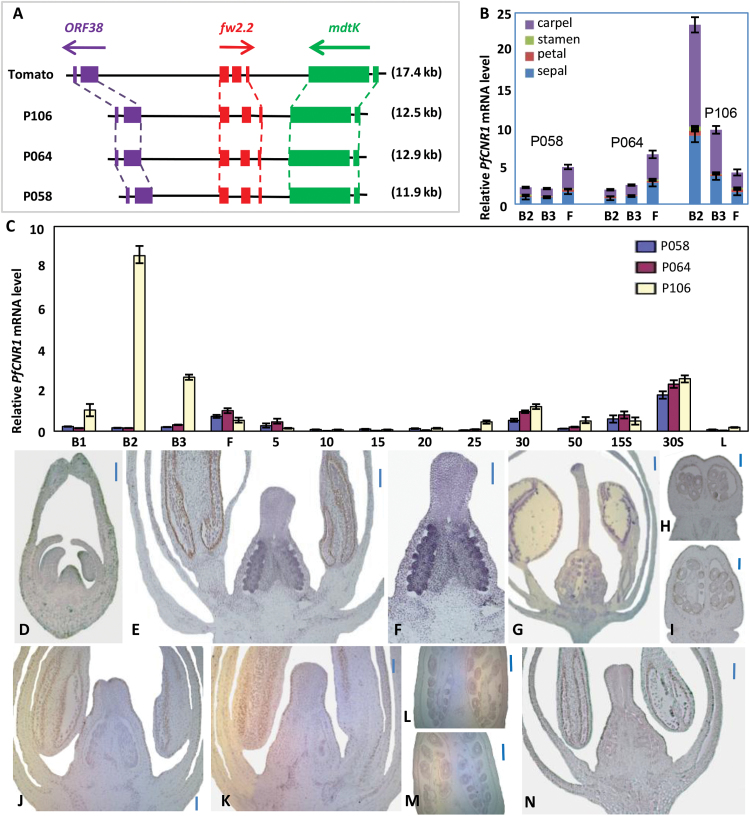
Characterizations of the PfCNR1 gene family. (A) Local synteny of FW2.2 and PfCNR1 between tomato and Physalis species. PfCNR1 genes were isolated from P. philadelphica (P058), P. philadelphica (P064), and P. floridana (P106). The upstream ORF38 of FW2.2 (PfCNR1) encodes an unknown protein, while the downstream gene is mdtK. The full length of each assembled genomic fragment is given in parenthesis. (B) PfCNR1 expression in four floral whorls at anthesis. P. philadelphica (P058), P. philadelphica (P064), and P. floridana (P106) were tested. (C) PfCNR1 expression in Physalis species. Developmental stages were defined as in Fig. 2A and B. 15S, seeds from 15 DPA; 30S, seed from 30 DPA; L, leaf. PfACTIN was used as an internal control. The experiments were performed using three independent biological samples. The mean and standard deviation are presented. (D–i) In situ hybridization of PfCNR1 in P. floridana P106: B1 flower bud (D); B2 flower bud (E); carpel of the B2 flower bud (F); B3 flower bud (G); carpel of the mature flower (H); 5 DPA fruit (I). (J–M) In situ hybridization of PfCNR1 in P. philadelphica P058 and P064: B2 flower bud of P058 (J); B2 flower bud of P064 (K); carpel of the mature flower of P058 (L); carpel of the mature flower of P064 (M). A PfCNR1 anti-mRNA probe was used in (D)–(M). (N) In situ hybridization of PfCNR1 in a B2 flower bud of P. floridana P106 using a PfCNR1 sense probe as a negative control. Bars, 100 μm. Developmental stages were identical as defined in Fig. 2A and B.